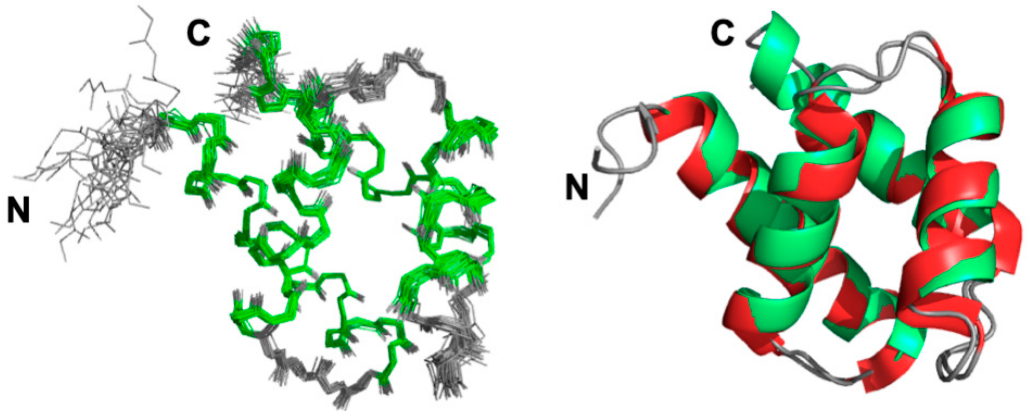
Figure 2. Solution structure of GIPC1-GH2. ( Left ) Overlay of the 20 best NMR structures (backbone atoms only) with lowest energy. The regular α -helices are colored in green. ( Right ) Superimposition of ribbon representations of the solution structure (with α -helices in green and the X-ray structure with α -helices in red) of the GH2 domain extracted from the structure of the full-length protein (PDB code: 5V6b).